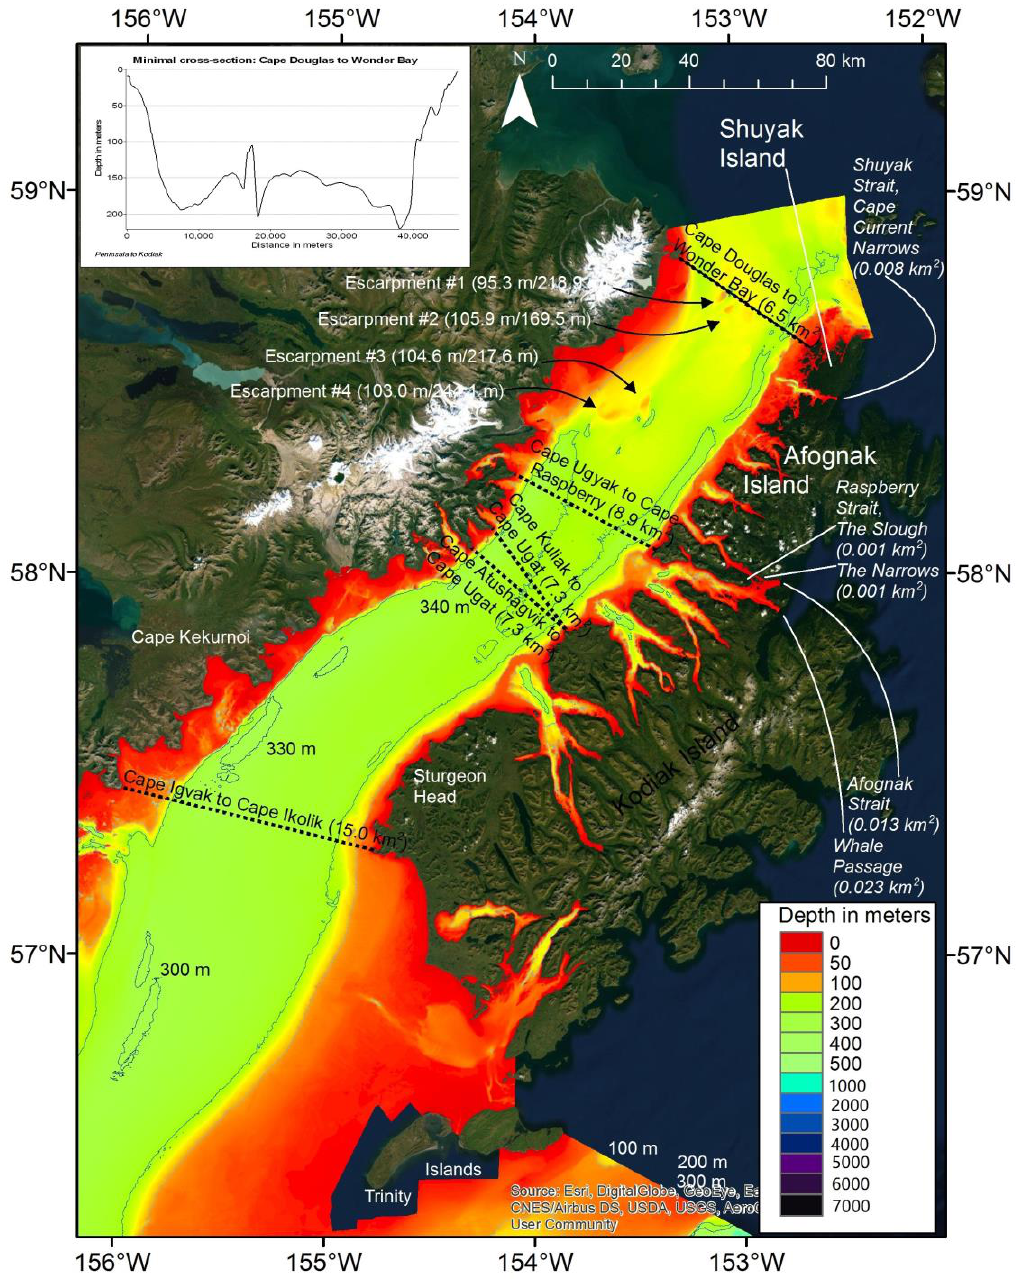
Figure 4. Cross-sections show the widest and narrowest areal openings of Shelikof Strait in the western Gulf of Alaska. Four prominent escarpments in the northwest section of Shelikof Strait are indicated along with their minimal and maximal depths. A graph shows the minimal cross-sectional opening of Shelikof Strait, ranging from Cape Douglas on the Alaska Peninsula to a location near Wonder Bay in the Kodiak archipelago.